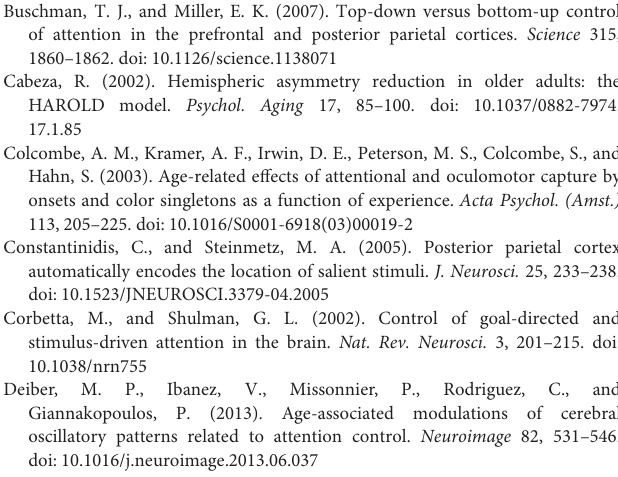
FIGURE S1 | Linear regression between mean reaction time (RT) and total coupling value for the pop-out condition with the left field target in the older group for theta frequency band. Each subject is marked as a circle, with 13 circles in total. Pearson correlation coefficient ( r = 0.588) was significant ( p = 0.035), indicating a positive linear correlation between RT and total coupling value in this